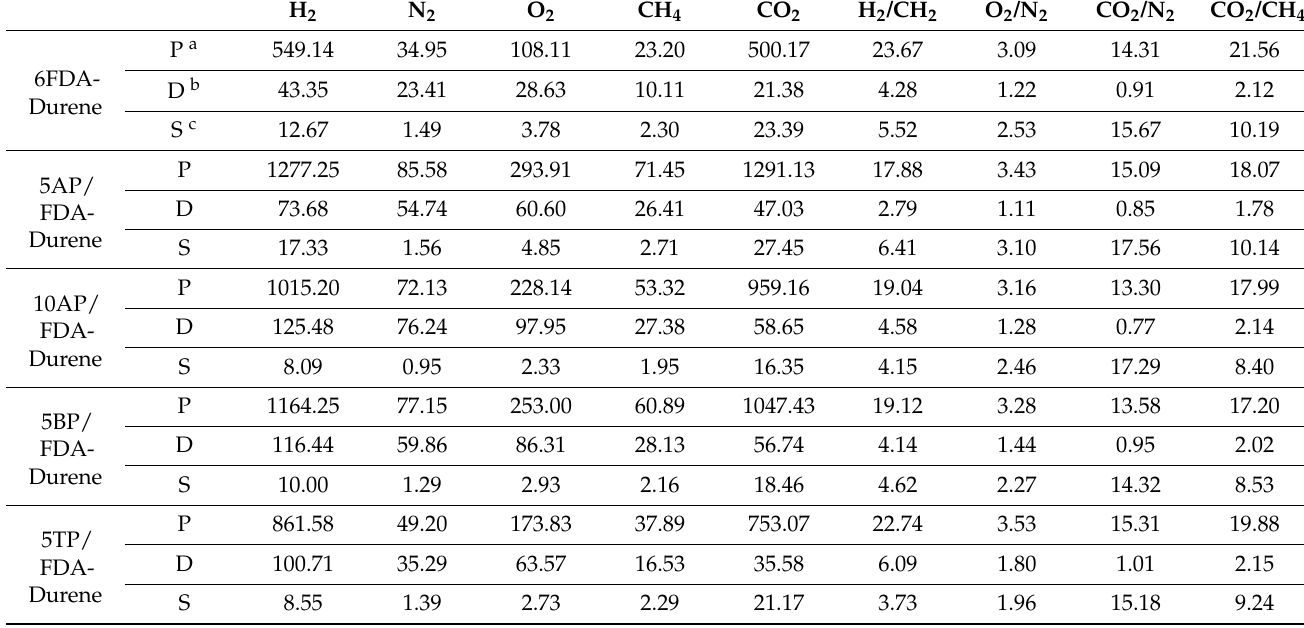
Table 4. Gas permeation and ideal selectivity of pristine membrane and “all polyimide” MMMs.